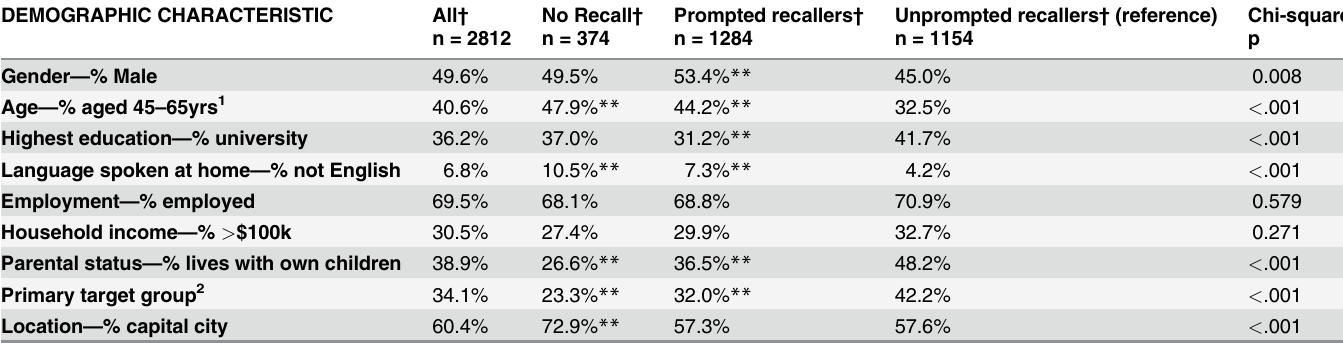
Table 2. Demographic profile for each level of Measure-Up campaign awareness (n = 2812).